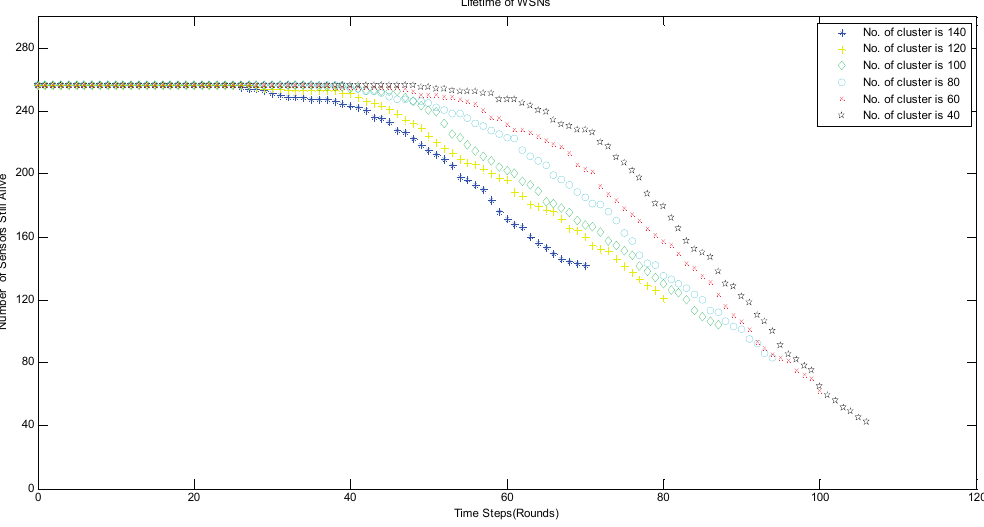
Figure 12. Lifetime of WSNs with different number of clusters.